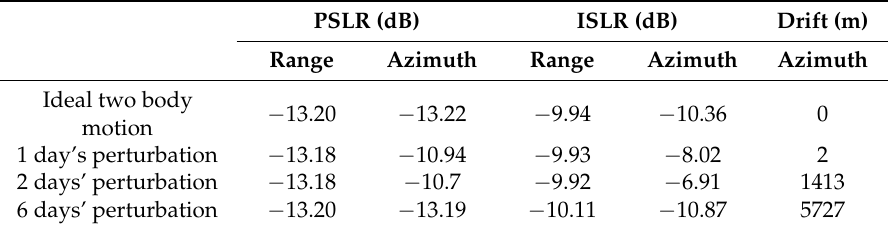
Figure 9. Imaging results of the perturbed GEO SAR point targets at perigee after the 1, 2 and 6 days’ perturbations. Table 9 . Evaluations of the perturbed GEO SAR point targets at perigee.